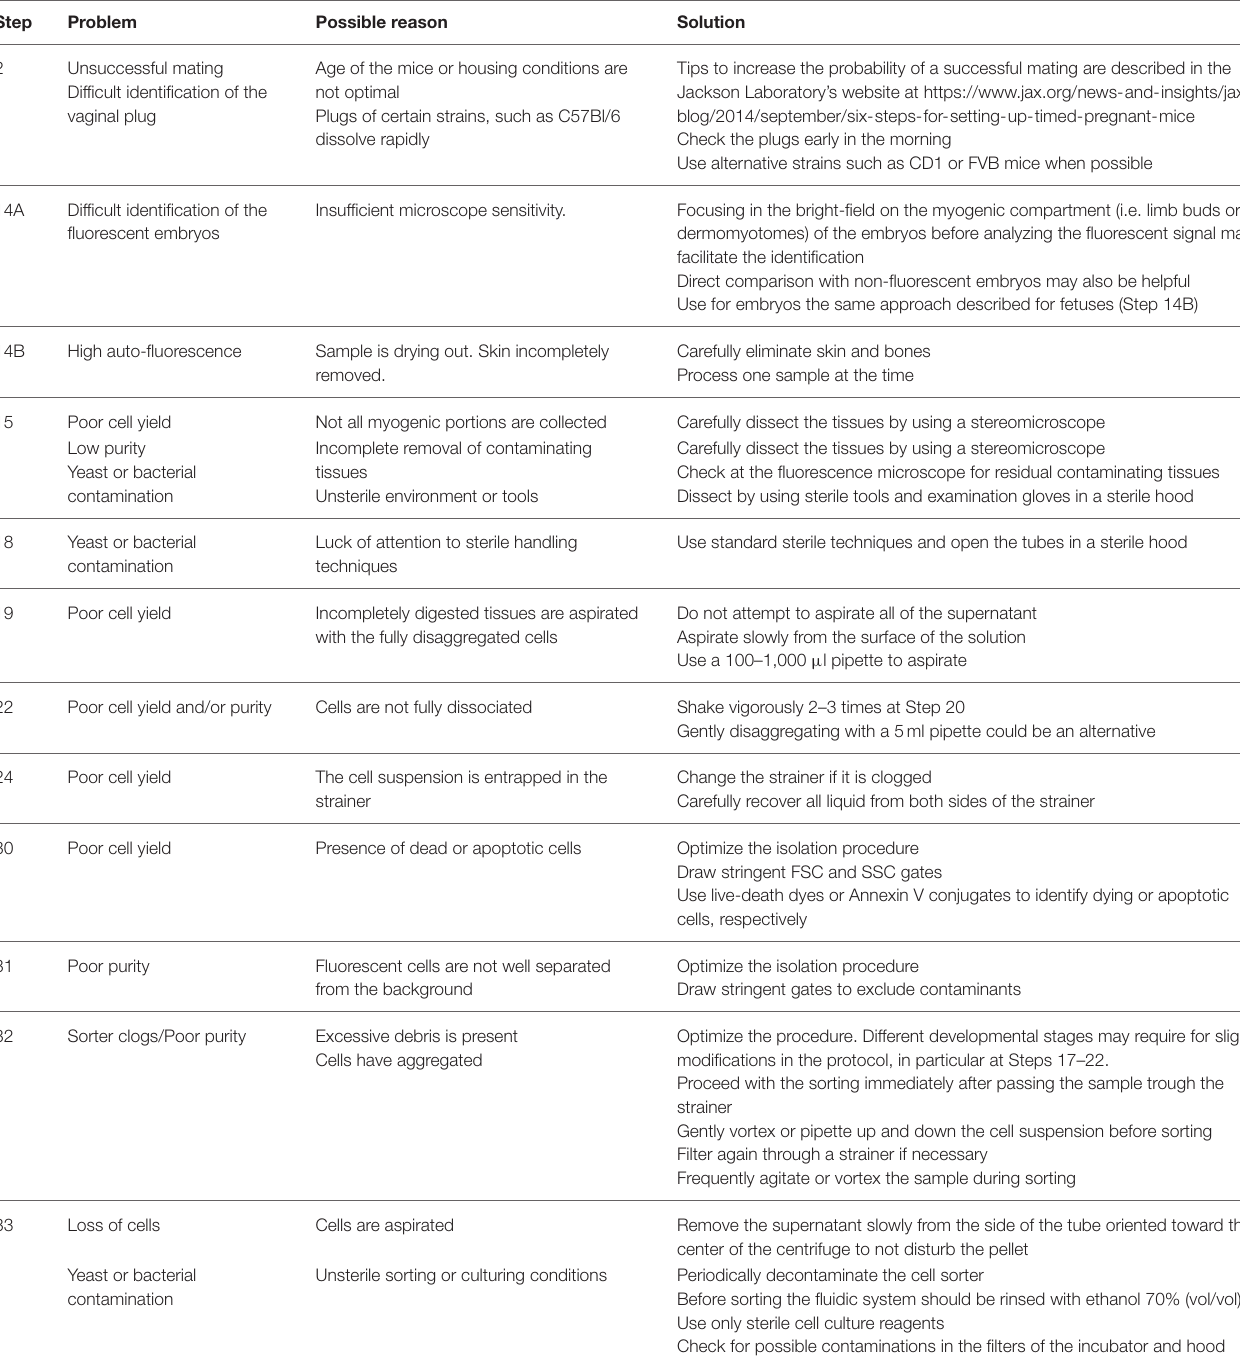
TABLE 2 | Troubleshooting